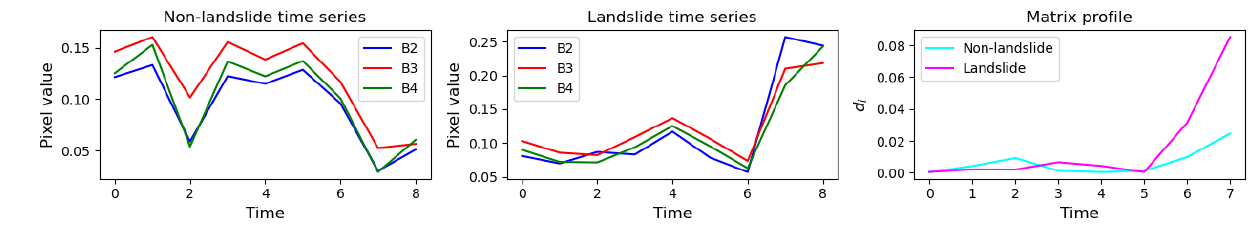
Figure 5. Example of time series in SITS. The first time series corresponds to a non-landslide region, whereas the second time series is extracted from the region where the landslide occurred. The matrix profile exhibit higher values for the time series that correspond to the landslide. Moreover, the change point (i.e., sample number 5) retrieved from the matrix profile corresponds to the immediate acquisition moment after the landslide occurred, i.e., 16 June 2017.